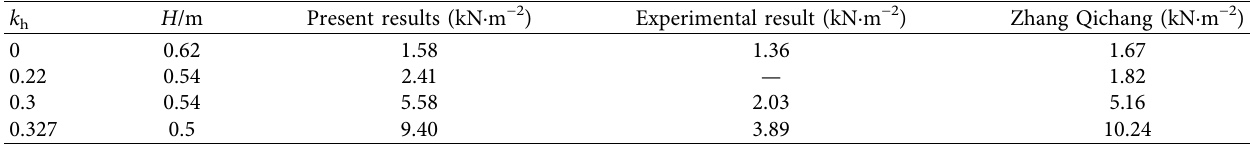
Table 1: Theoretical analytical solution and measured results.